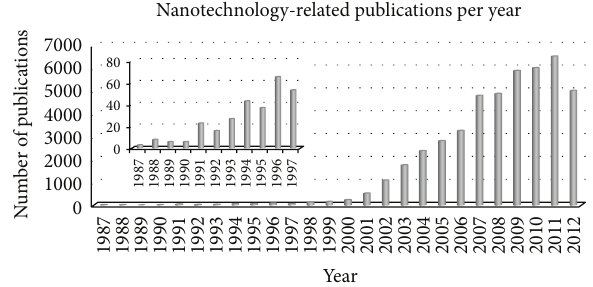
Figure 1: Development of the number of publications per year in the field of nanotechnology since 1987 (based on a research on Thomson Reuters’ Web of Knowledge database; http://www.webofknowledge.com/ last visited 16.01.2013 the value for 2012 is likely to increase as not all 2012 papers are already published